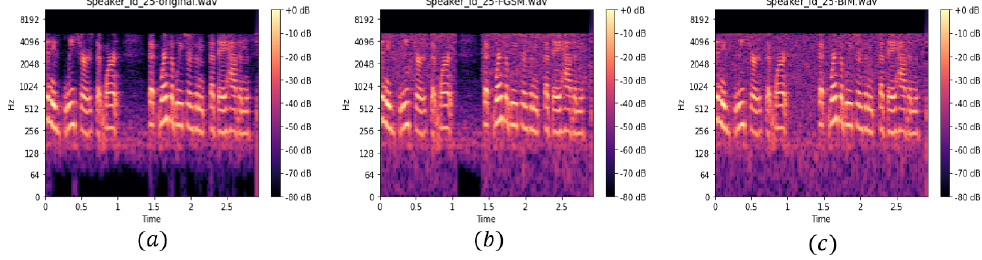
Figure 8. A example of the Mel spectrograms of audios after introduction of FGSM- and BIM-based time-domain perturbations. Figure ( a ) shows the spectrogram of the original audio, while figure ( b , c ) show the spectrograms of the adversarial audio generated by the FGSM and BIM algorithms